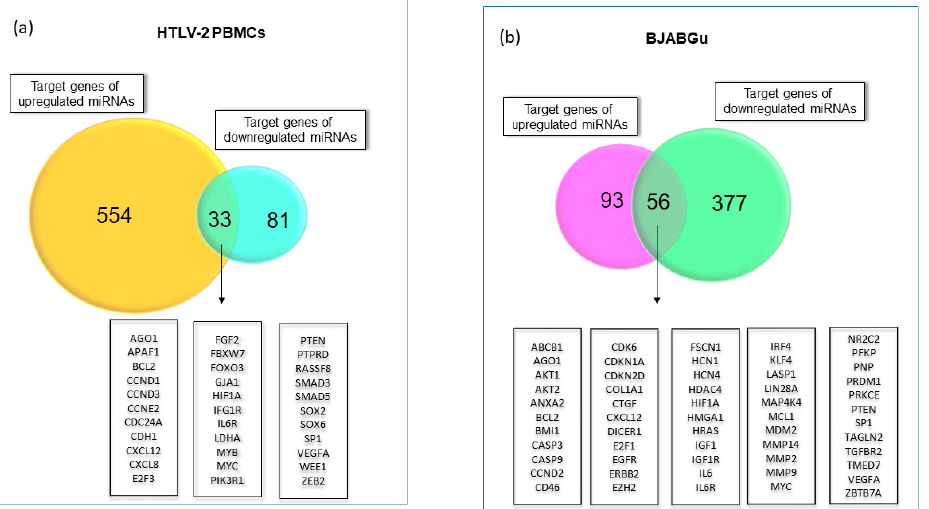
Figure 2. Target genes of deregulated miRNAs. The Venn diagram indicates the target genes of differentially expressed (down or upregulated) in HTLV-2-infected PBMCs ( a ) and BJABGu ( b ). The target genes that are common between the two groups are listed in the boxes.